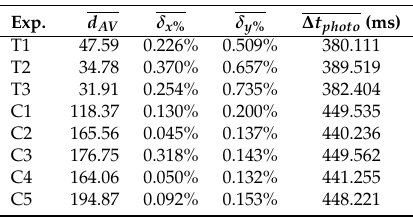
Table 3. Final registration